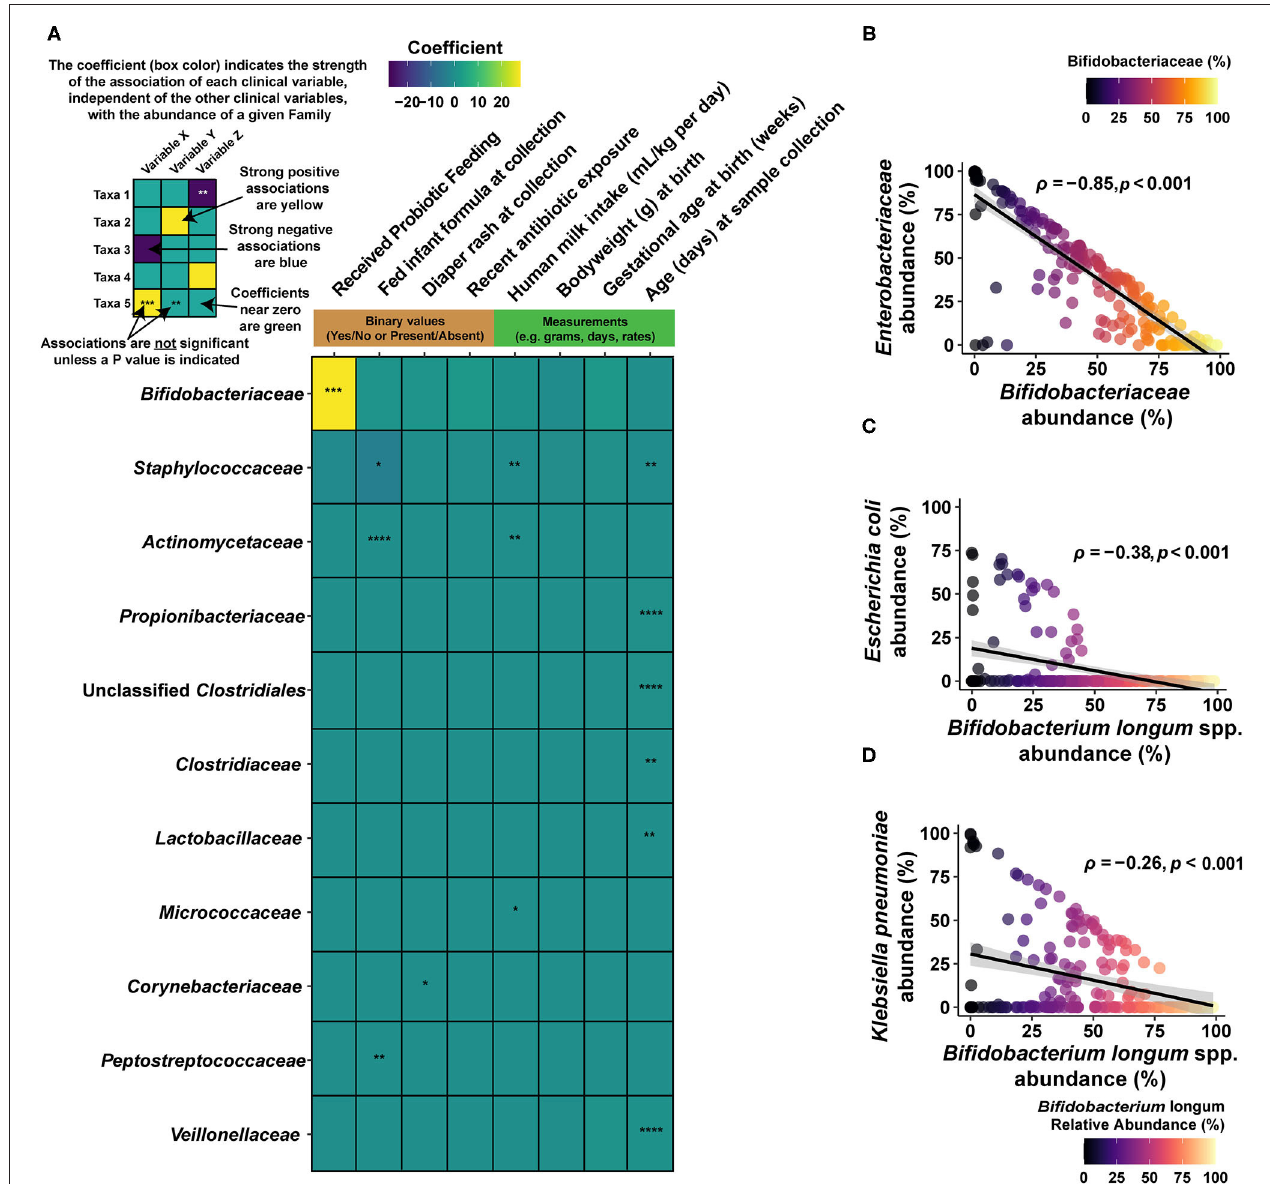
FIGURE 2 | Associations between gut taxa and clinical interventions. (A) Heat map describing the output of multivariate analysis of individual clinical variables (columns) with family-level microbial groups. This approach separates the effects of individual clinical variables and reports the impact of each one, individually, on the abundance of the given bacterial family (row). Significant associations are indicated by the notation of the FDR-adjusted P value (asterisks), and the degree of the interaction (coefficient) is indicated by the color scale. Strong, positive associations between a given clinical variable (column) and the bacterial family (row) are indicated in yellow, while strong negative associations between a clinical variable and a bacterial family are indicated by dark blue. Weak associations (i.e., close to 0) are indicated in green. Only bacterial families that included a significant association prior to FDR correction are shown. As Bifidobacteriaceae are strongly linked to probiotic intervention (as indicated by the yellow tile), we examined interactions between this family and its constituents and other bacterial groups among infants fed B. infantis EVC001. (B) At the family level, Bifidobacteriaceae are strongly negatively correlated with Enterobacteriaceae , as assessed using relative abundance and Spearman’s rho ( ρ ), among infants fed B. infantis EVC001. Points are shaded based on the abundance of Bifidobacteriaceae . This is also true for two of the primary constituents of the Enterobacteriaceae family. (C) E. coli and B. longum species are negatively correlated among infants fed B. infantis EVC001. (D) B. longum is negatively correlated with K. pneumoniae among infants fed B. infantis EVC001 (FDR-adjusted P values are indicated by asterisks, **** P < 0.0001 ; *** P < 0.001 ; ** P < 0.01 ; * P < 0.05 ). 17.76% SD) vs. 3.29% ( + / − 10.02% SD)] when comparing samples from infants not fed B. infantis EVC001 to infants fed the